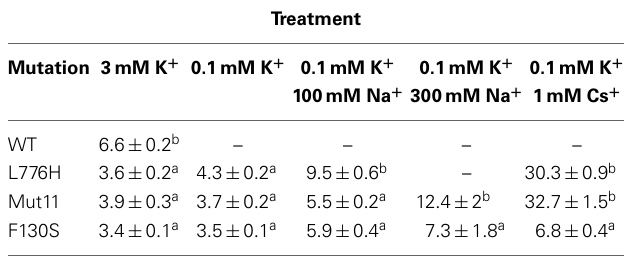
Shown are mean values of at least three replicates ± standard error. Different letters indicate significant differences within each column according to Tukey test (p <